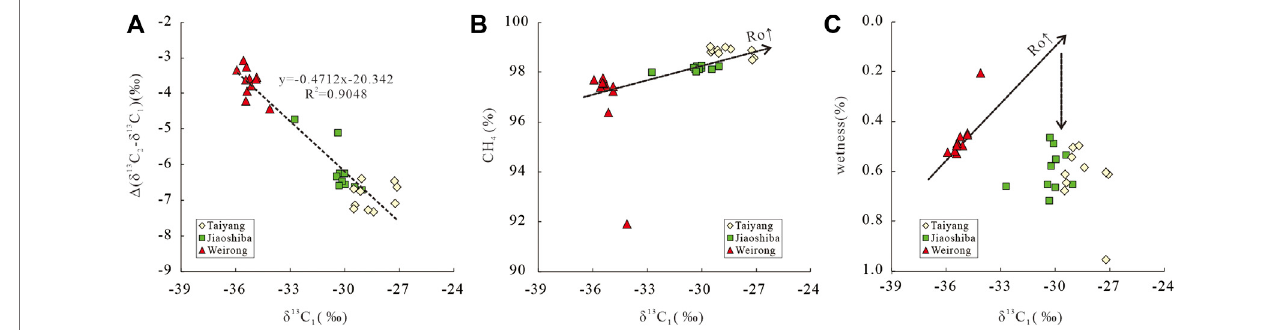
FIGURE9| BoxplotoftheCO 2 contentintheshalegasesfromTaiyang, Jiaoshiba, and Weirong shale gas fi elds in the Sichuan Basin.